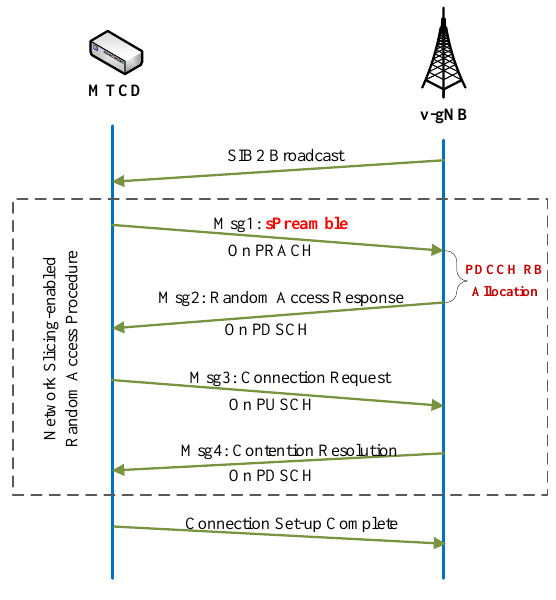
Figure 2. Network slicing-enabled random access procedure.